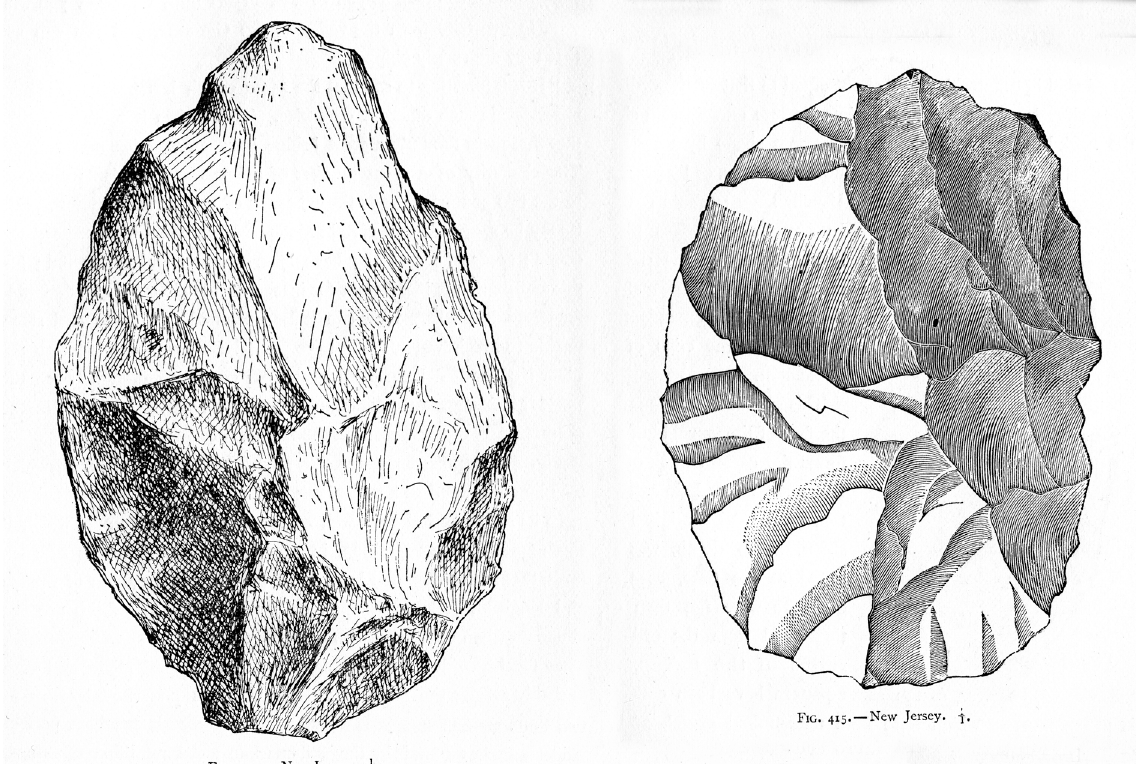
Figure 1. Paleoliths from Trenton, New Jersey. Artefact on the left is ca. 12 cm in length. Source Abbott 1881: figs. 414 and